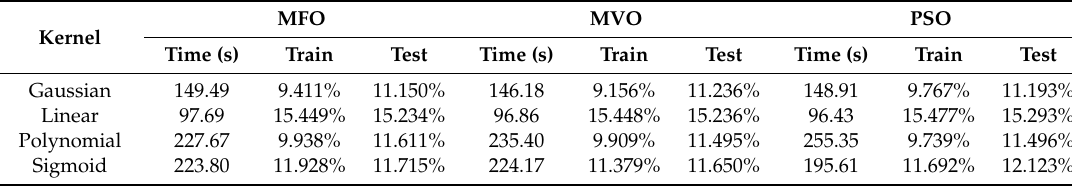
Table 5. Results of optimizing the kELM by di ff erent search